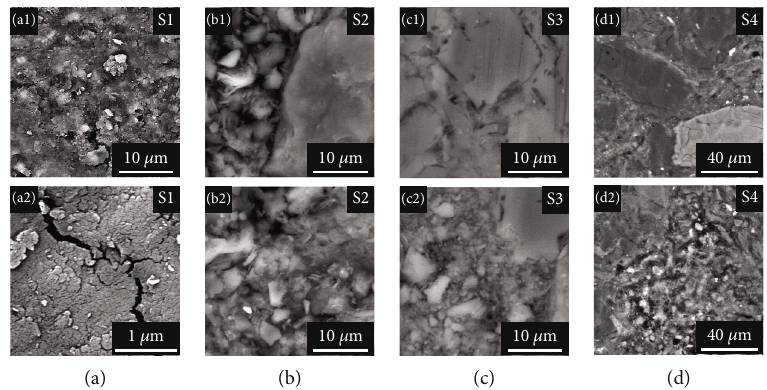
Figure 15: Pores in the four red mudstone samples: (a) sample S1, (b) sample S2, (c) sample S3, and (d) sample